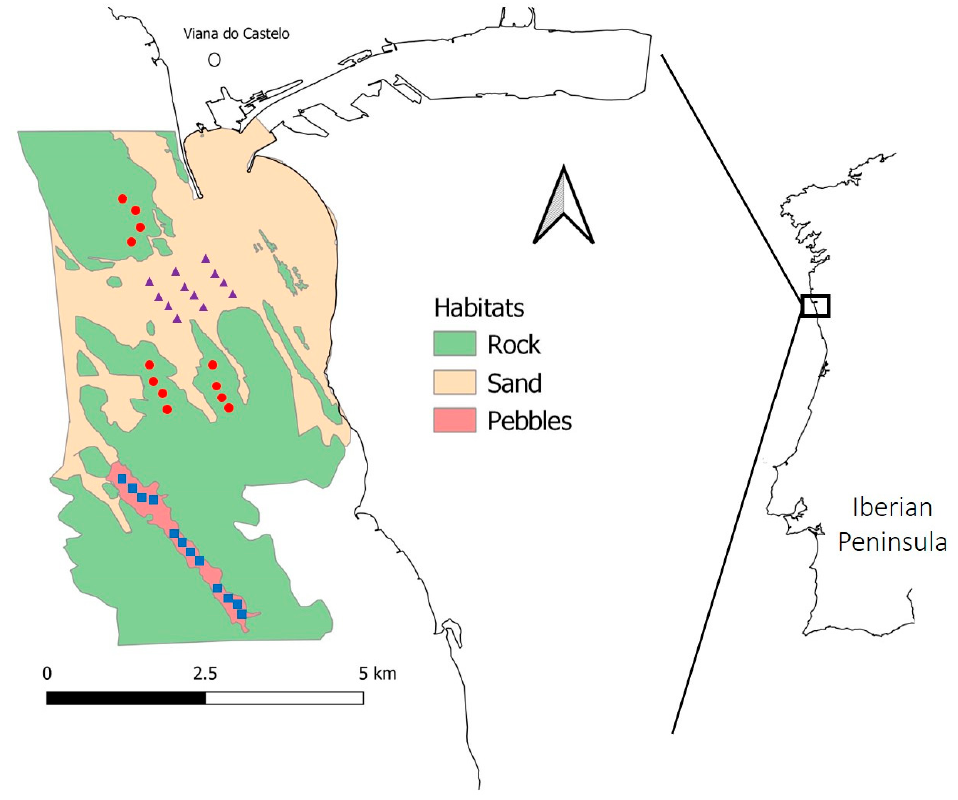
Figure 1. Main bottom habitats on the shallow coast of Viana do Castelo (<30 m depth) and baited trap deployment sites. Red dots indicate baited traps deployed in rocks; pink triangles indicate baited traps deployed in sand; blue squares indicate baited traps deployed in pebbles.